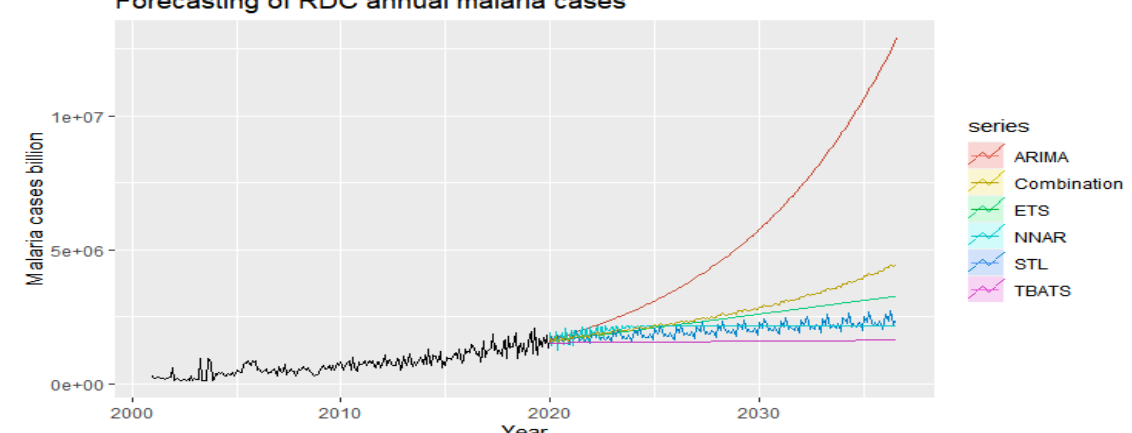
Figure 13. Point forecasts from various applied methods of malaria episodes in DRC.